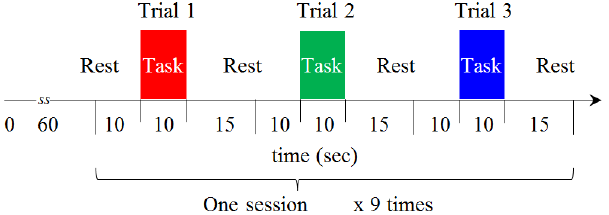
Fig. 2. Experimental RGB-color paradigm: One trial consists of a 10 s rest, a 10 s color stimulation, and a 15 s rest; three continuous trials of each color stimulation constitutes one ses- sion; one experiment consists of nine sessions (total time 947 s).